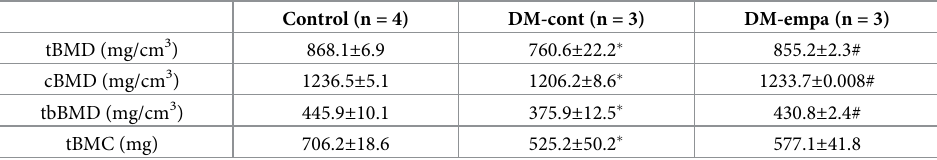
Bone densitometric analysis of femurs in rats after 12 weeks. Abbreviations: tBMD, total bone mineral density; cBMD, cortical bone mineral density; tbBMD, trabecular bone mineral density; tBMC, total bone mineral content. Data are represented as mean ± SE. � p < 0.05 vs